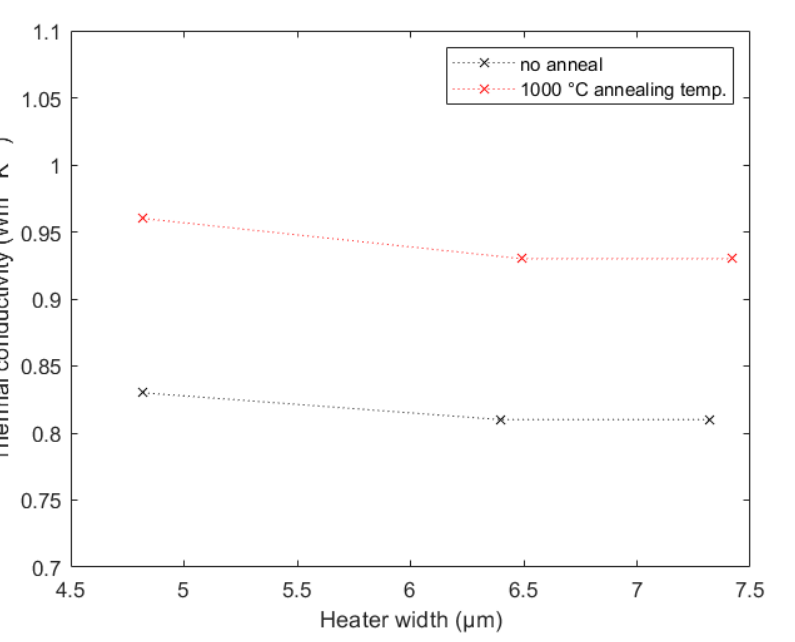
Table 6. Final thermal conductivity measurement results for the different Al 2 O 3 samples.